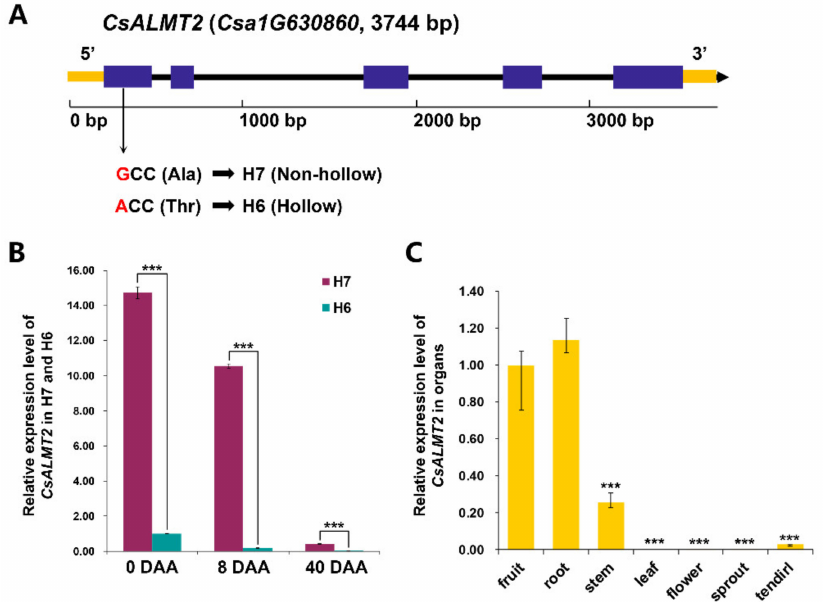
Figure 4. Gene structure and expression analysis of CsALMT2 : ( A ) Gene structure of the predicted CsALMT2 . Purple represents exons, solid lines represent introns, and yellow represents 5 (cid:48) -UTR and 3 (cid:48) -UTR; ( B ) relative expression levels of CsALMT2 in H7 and H6 fruit at different growth stages. Bars are means of three replicates ± SEM. Triple asterisk, p < 0.001; ( C ) relative expression levels of CsALMT2 in H7 different tissues. Bars are means of three replicates ± SEM. Triple asterisk, p < 0.05.